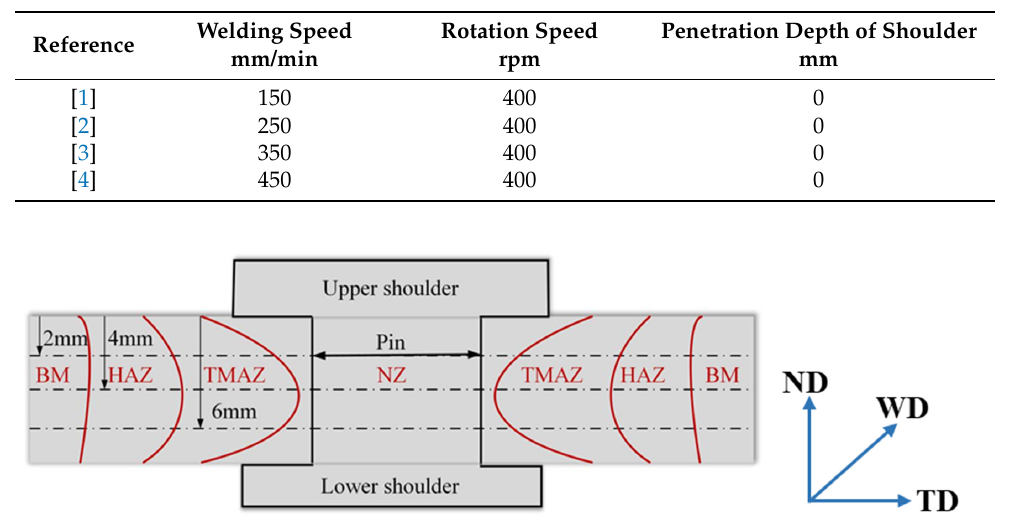
Table 2. The Experimental Conditions.